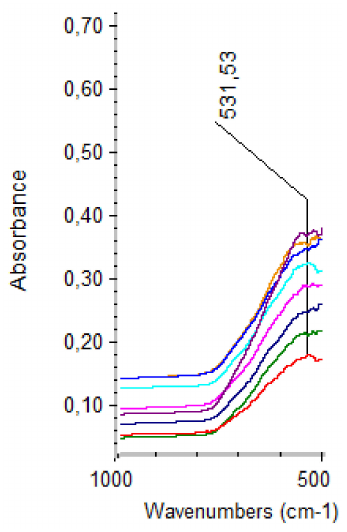
the absorption band at 531.53 cm − 1 characteristics to the Fe-O vibration in magnetite [36–39].